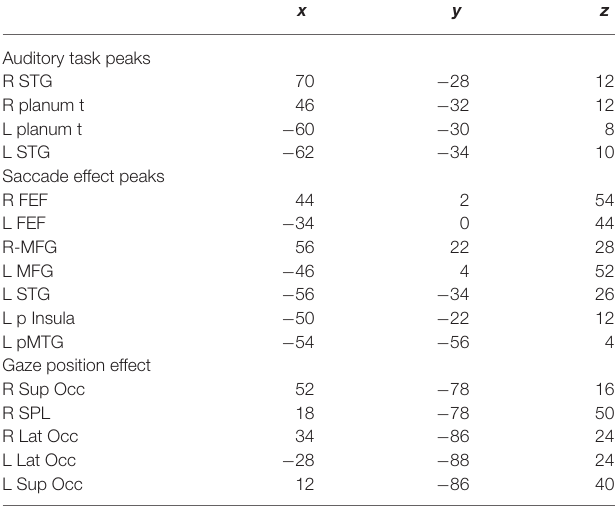
TABLE 1 | MNI coordinates for local maxima of task activation map and individual differences in eye movement maps shown in Figure 4. x y